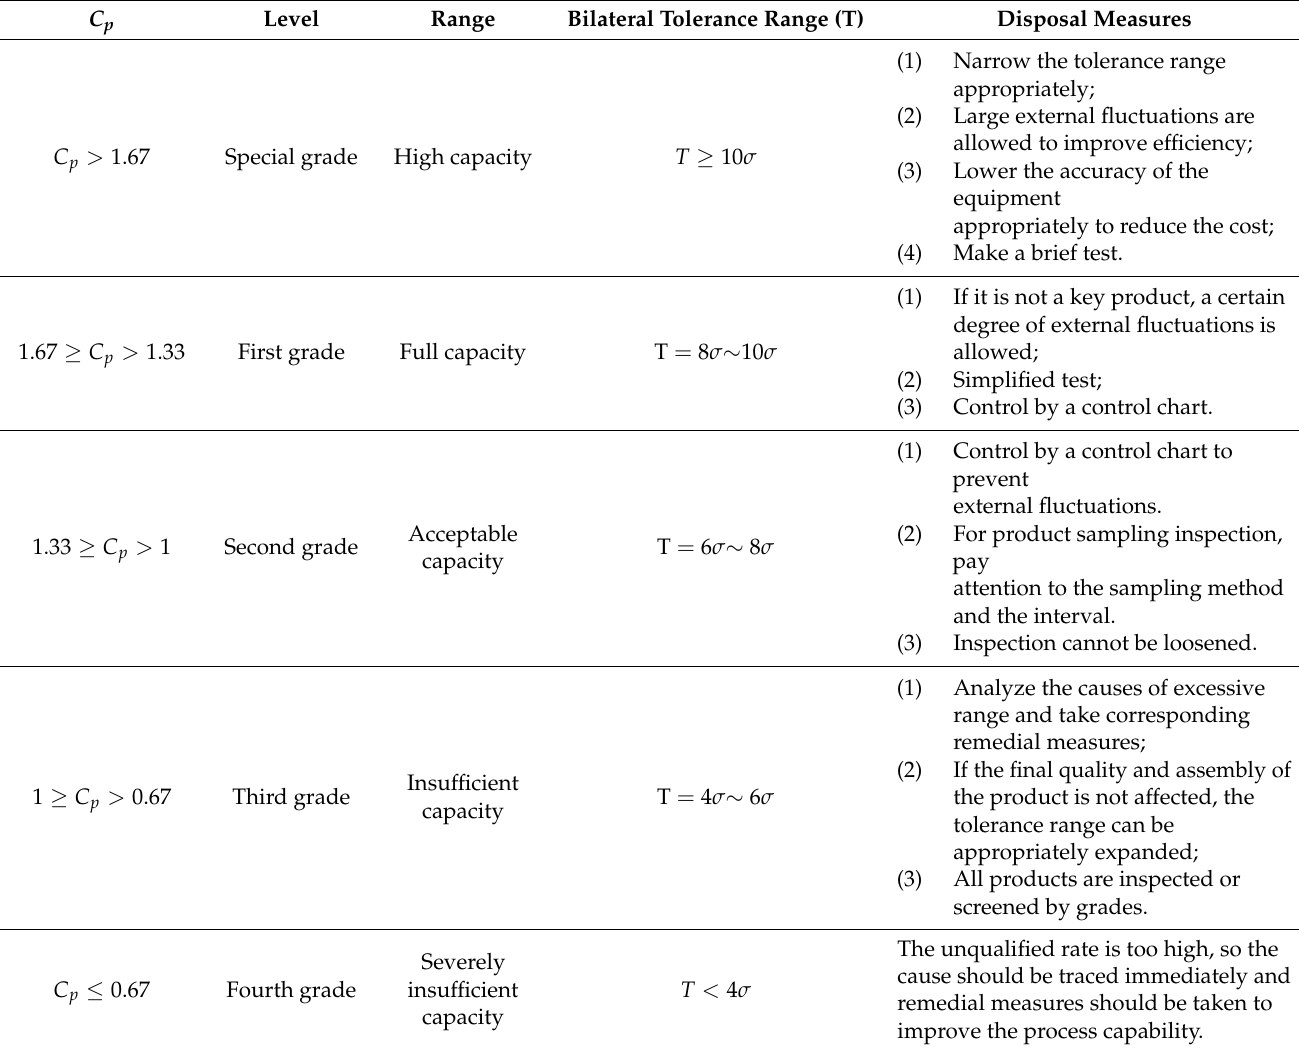
Table 2. Grading judgment and disposal of process capability